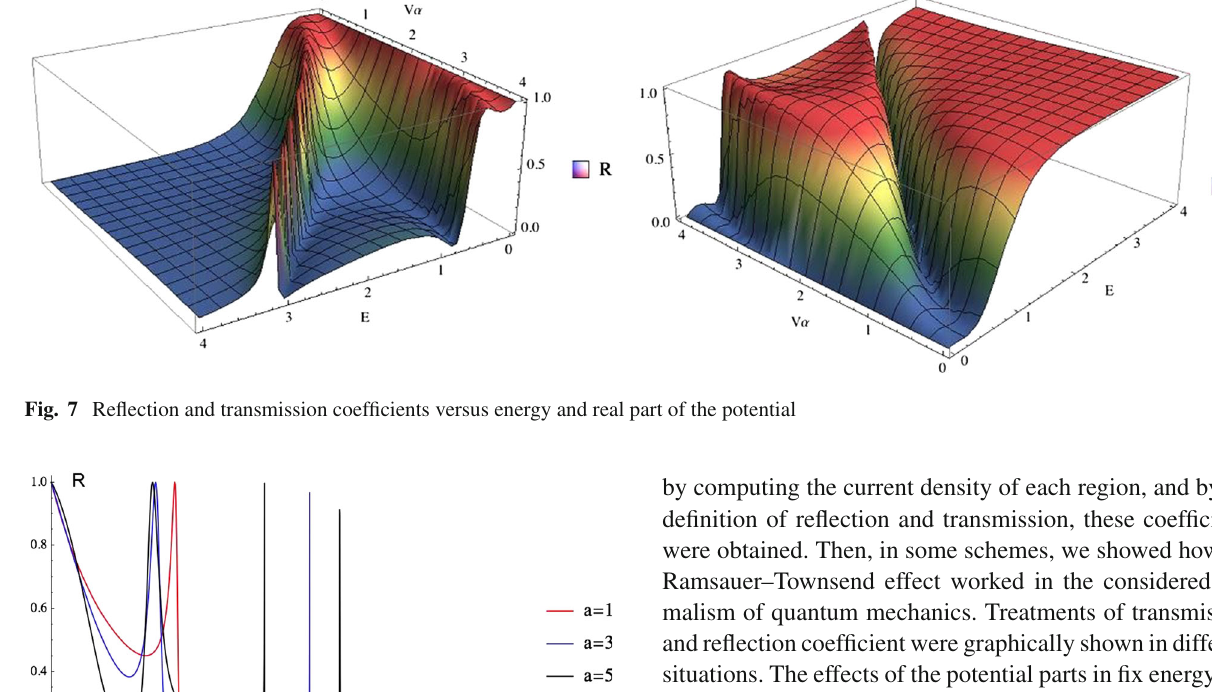
before. In this figure transmission vs. energy is plotted with V α = 3 , V β = 0 . 5 + i 0 .